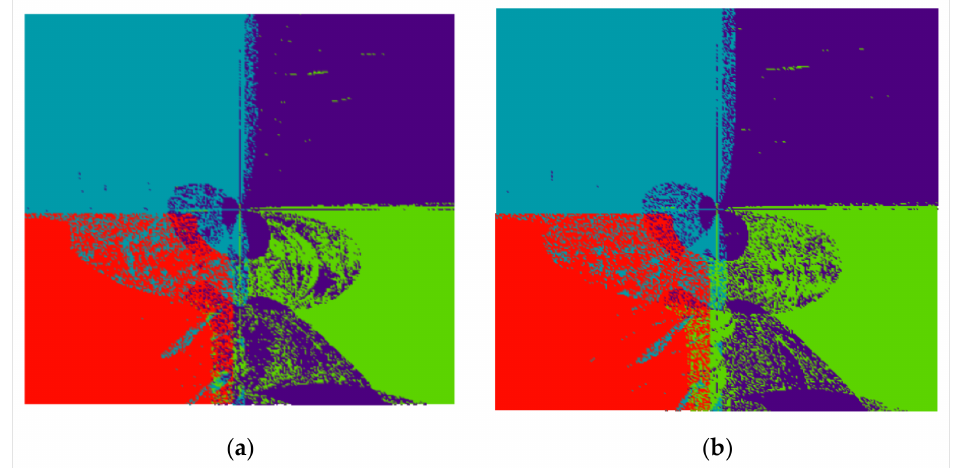
Figure 21. “Portrait” of the numerical search for the minima of the Himmelblau’s function obtained by the Conjugate Gradient ( a ) and Quasi-Newton ( b ) method.